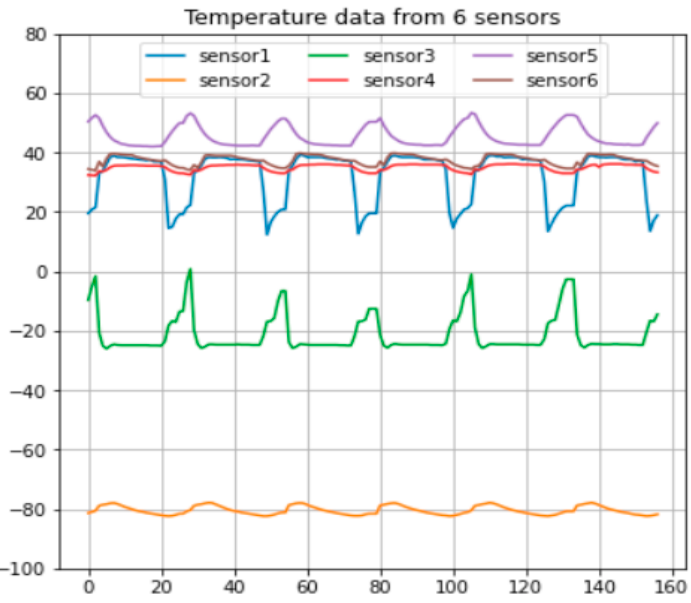
Figure 10. Comparison graph of temperature data from six sensors.